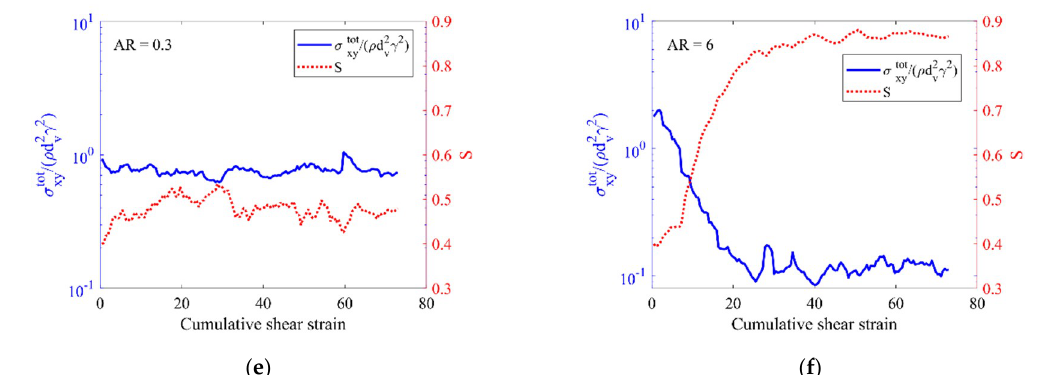
Figure 6. Evolution of normalized shear stress, average stack size R ave (first row), fraction of stacking particles P (second row), and order parameter S (third row) with cumulative shear strain for the monodisperse shear flows with disks of AR = 0.3 (first column) and rods of AR = 6 (second column): ( a ) R ave versus cumulative shear strain for AR = 0.3, ( b ) R ave versus cumulative shear strain for AR = 6, ( c ) P versus cumulative shear strain for AR = 0.3, ( d ) P versus cumulative shear strain for AR = 6, ( e ) S versus cumulative shear strain for AR = 0.3, ( f ) S versus cumulative shear strain for AR = 6. The solid volume fraction is ν =